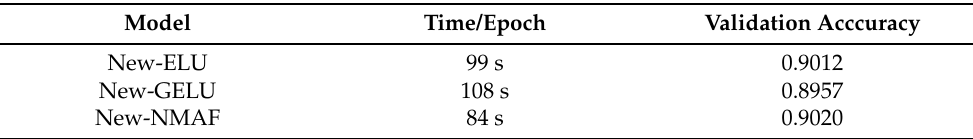
Table 12. Validation accuracy and run time of Intel images classification dataset performed with our proposed model with ELU, GELU, and our NMAF activation